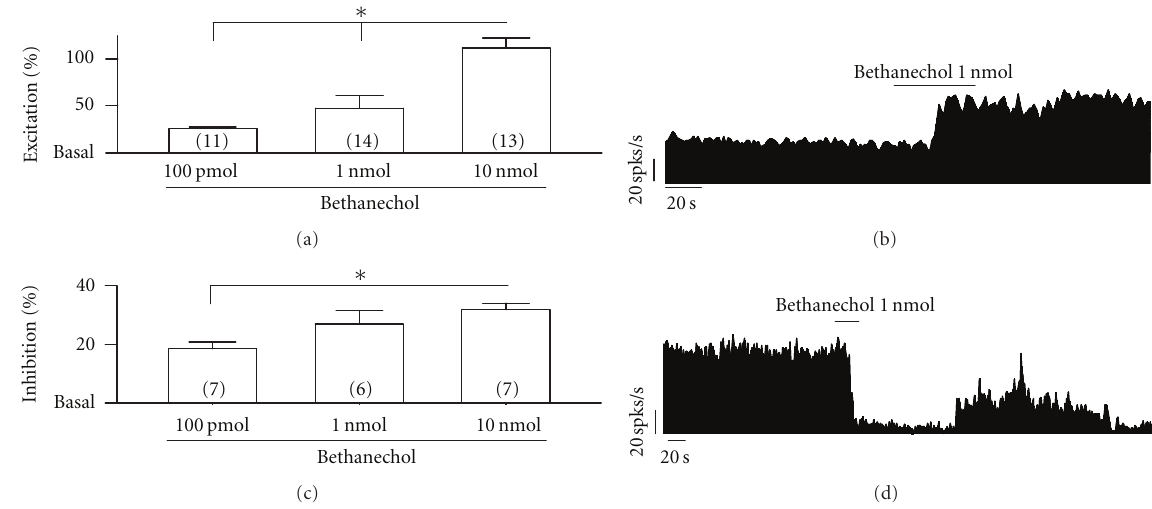
Figure 1: Intrapallidal activation of MRs produces heterogeneous e ff ects on the baseline firing rate of globus pallidus neurons recorded in normal rats. (a) Bethanechol 100pmol, 1 and 10nmol increases the spiking rate in a dose-dependent manner ( ∗ P < 0 . 05 as compared to bethanechol 100 pmol and 1nmol. One-way ANOVA, Newman-Keuls post-hoc test). (b) Frequency histogram showing the increase in baseline firing rate induced by local application of 1nmol bethanechol. (c) In another group of globus pallidus neurons, bethanechol decreases the spiking rate in a dose-dependent manner. ( ∗ P < 0 . 01, as compared to 100 pmol bethanechol, one-way ANOVA, Newman- Keuls post-hoc test). (d) Frequency histogram illustrating the inhibitory e ff ect of 1nmol bethanechol on a pallidal neuron. spks/s, spikes per second.